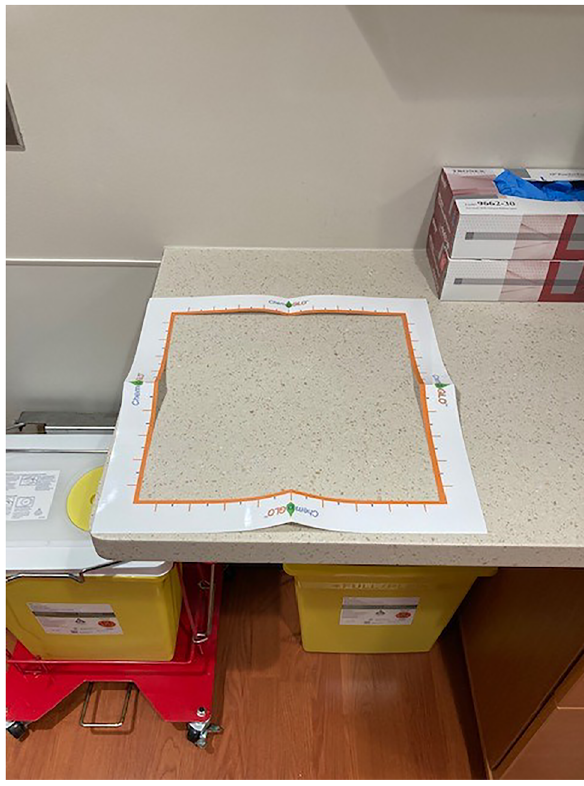
Figure 3: HD sampling area of the nursing staging area.